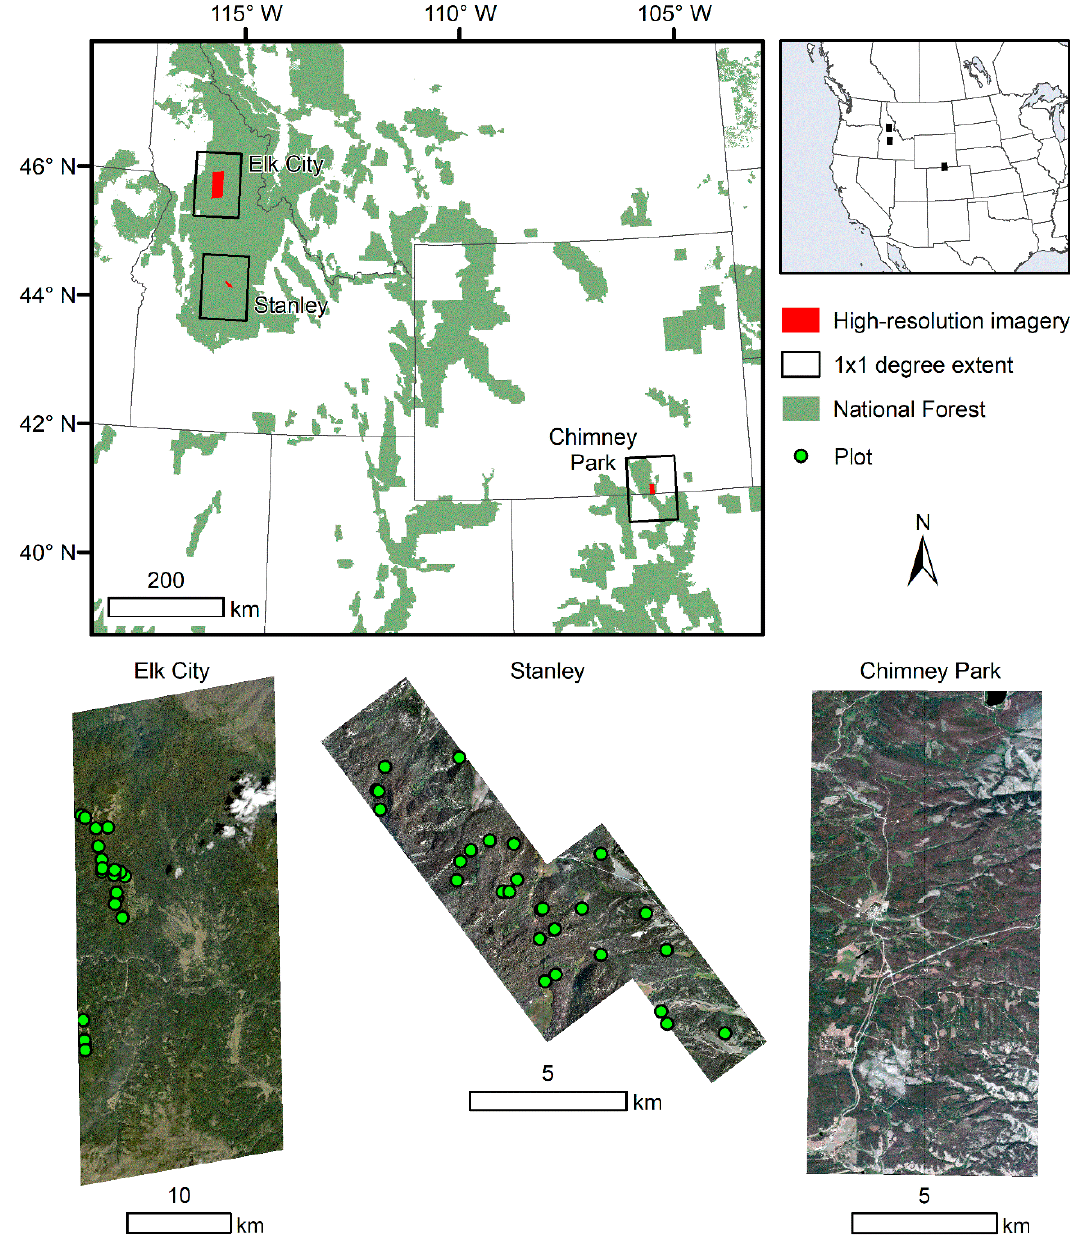
Figure 1. Study areas near Elk City and Stanley, Idaho, and Chimney Park, Wyoming, United States. Models predicting percent tree mortality were developed in areas of high-resolution multispectral imagery. Models were then applied to time series of Landsat imagery within 1 × 1 degree extents.